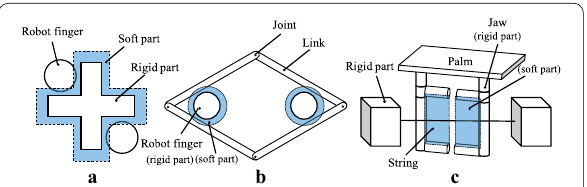
a Fig. 3 Three types of deformable objects. a Rigid object covered with a soft part, b closed-loop structure, and c two rigid bodies connected with a